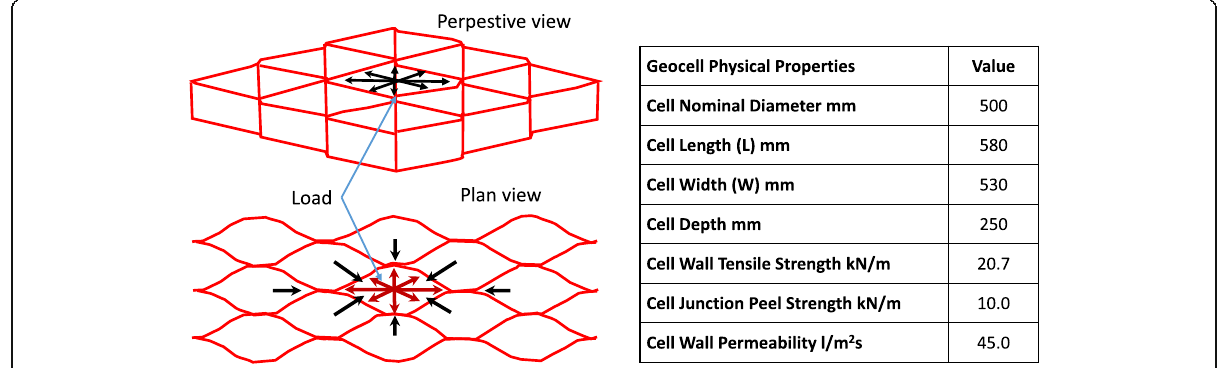
Fig. 5 Schematic drawing of typical geocell and physical, mechanical and hydraulic parameters